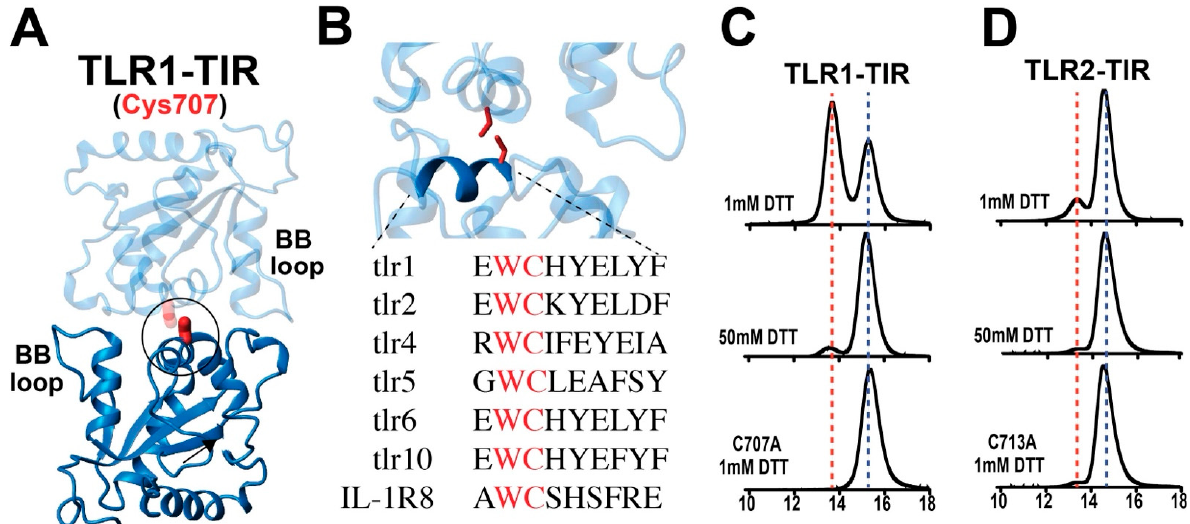
Figure 5. TLR1-TIR and TLR2-TIR homodimerization. ( A ) A conserved cysteine, C707 (red), within the crystallographic homodimer in TLR1 is shown (PDB accession 1fyv). ( B ) The cysteine is partially buried by the conserved BB-loop and is conserved within multiple TLR TIR domains and the IL-1R8-TIR domain. ( C ) Analytical Superose-12 of recombinant TLR1-TIR in 1 mM DTT (top), incubated for 30 min in 50 mM DTT (middle), and the TLR1-TIR C707A mutant in 1 mM DTT (bottom). ( D ) Analytical Superose-12 of recombinant TLR2-TIR in 1 mM DTT (top), incubated for 30 min in 50 mM DTT (middle), and the TLR2-TIR C713A mutant in 1 mM DTT (bottom). Buffer for analytical sizing was 50 mM Na 2 HPO 4 , pH 6.5, 150 mM NaCl, 1 mM DTT.